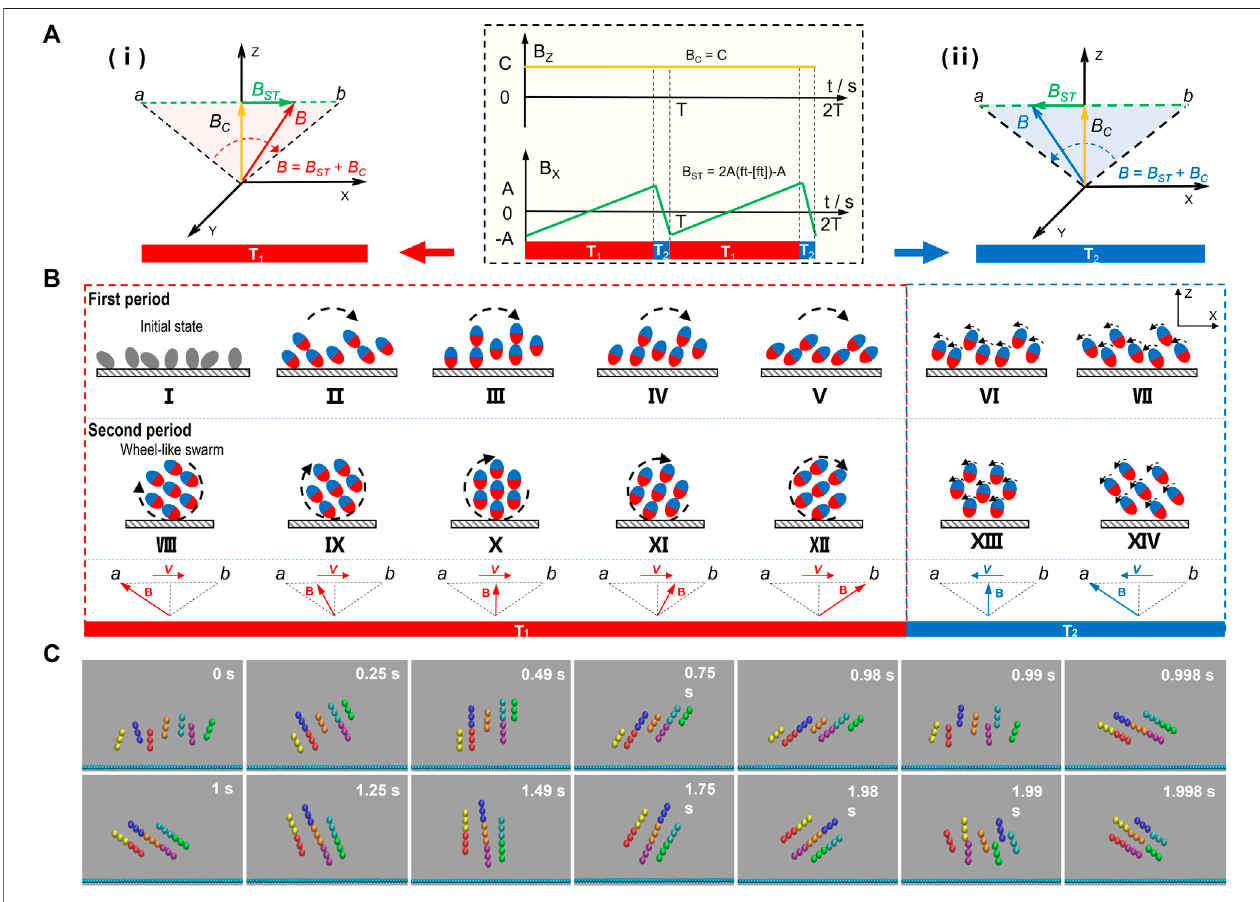
FIGURE 1 | Formation mechanism of vertical wheel-like swarm. (A) Schematic diagram in the yellow shadow shows the wave forms of sawtooth fi eld B ST (green) and the uniform fi eld B C (orange). In the x direction, a sawtooth magnetic fi eld B ST is applied, with the condition of B ST = 2 A ( ft − [ ft ]) − A . In the z direction, a uniform magnetic fi eld B C is applied, with a constant fi eld strength of C . The schematics in red and blue shadow illustrate the synthesis principle of swing magnetic fi eld. (i) The synthetic fi eld B (red) swings forth slowly in stage T1. (ii) the synthetic fi eld B (blue) wiggles back quickly in stage T2. (B) Schematic illustration of rotary stepping mechanism.Theredandblueellipsesrepresenttinymagneticunitsself-organizedfromparamagneticnanoparticles.Thepartsinredorbluestandformagneticpoles.(I- XIV) demonstratetheformationprocessofverticalwheel-likeswarm. (C) Thedynamicsequence pro fi leofawheel-likeswarm triggeredbysyntheticmagnetic fi eldof γ = 3 and f = 1 Hz. Trimers in different colors represent tiny chains self-organized from paramagnetic